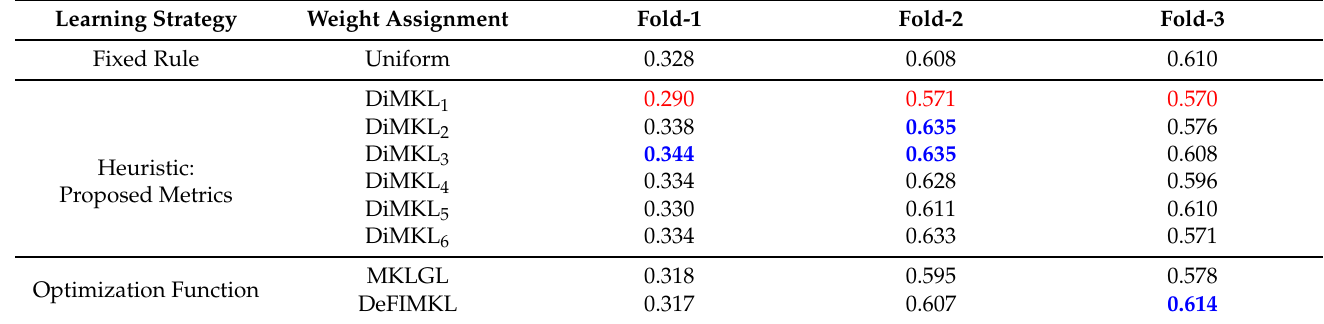
Table 4. Experiment 2: Fusing four RBF kernels—one for each iECO descriptor grouping and the pre-screener score. MAUC values are reported for each fold and MKL technique. Highest performing method is shown in blue; lowest performing is shown in